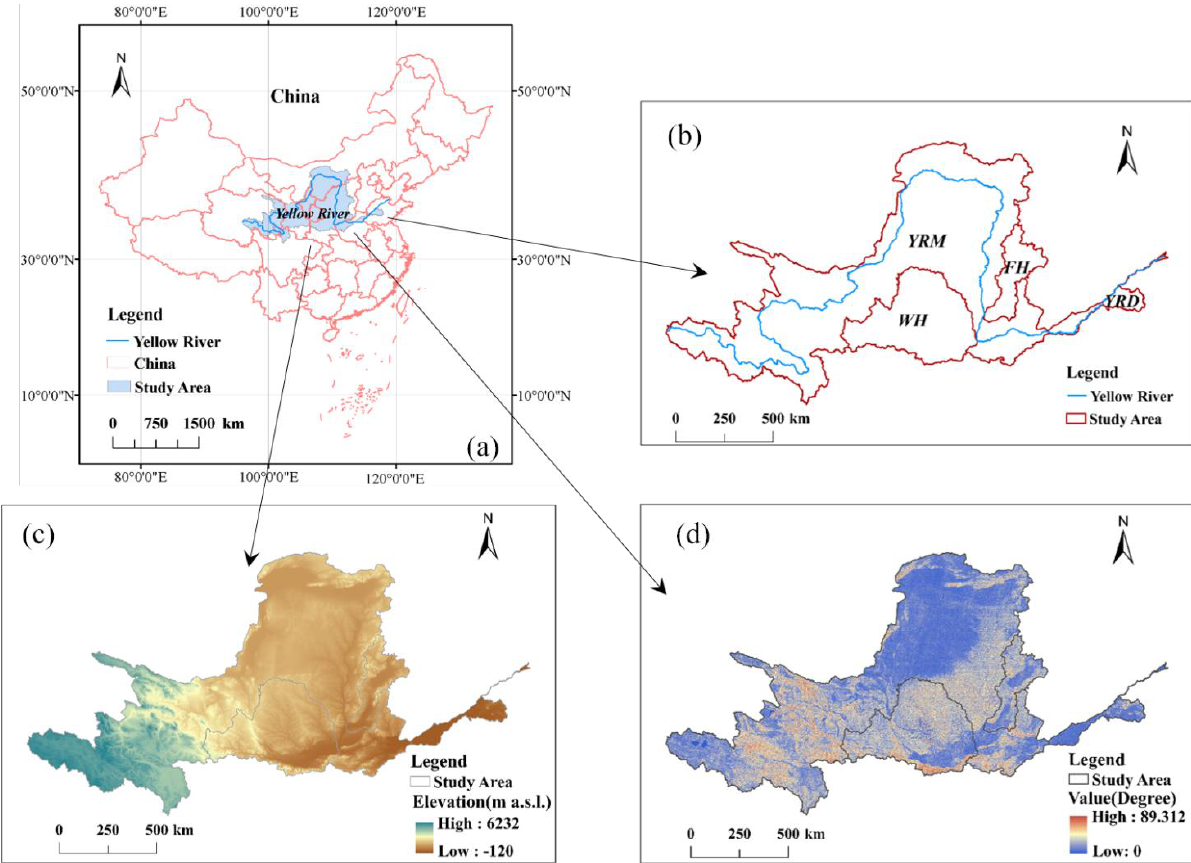
Figure 1. Study Area: ( a ) Location of the Yellow River Basin in China; ( b ) Location of the Yellow River sub-basins; ( c ) Digital elevation model of the Yellow River Basin and its sub-basins; ( d ) Slope of the Yellow River Basin and its sub-basins. YRM, Mainstream Basin; WH, Weihe River Basin; FH, Fenhe River Basin; YRD, Yellow River Downstream Basin.